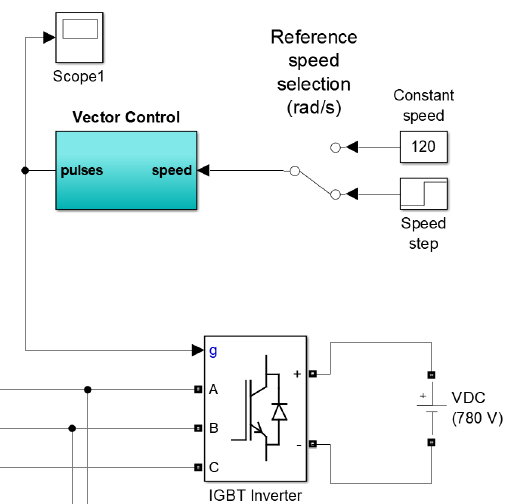
Figure 4. Model of IM control with measurement of signals on IGBT transistors gates forming PWM.